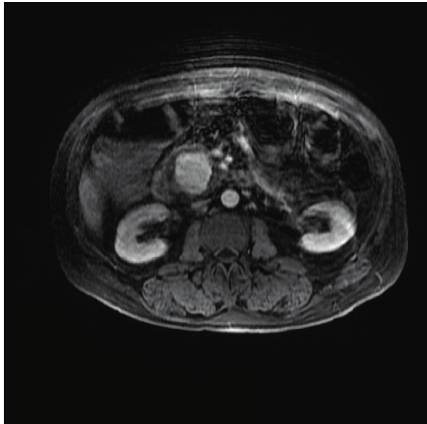
Figure 4: Magnetic resonance imaging without measurement of pseudoaneurysm.